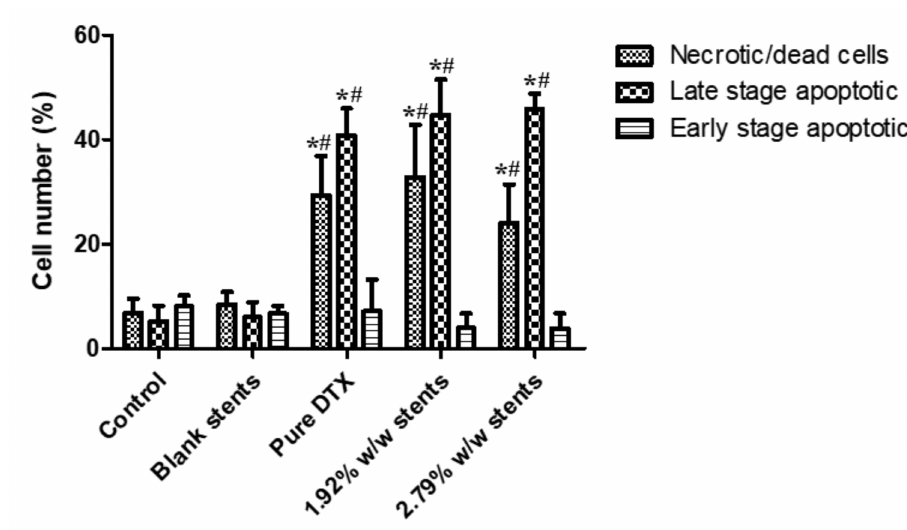
Figure 6. Apoptosis progression in KYSE30 esophageal cancer cells after treatment with blank (drug- free) stent, pure DTX drug (1 µ g/mL) and DTX-loaded stent samples for 48 h, as analysed by flow cytometry-based annexin V-FITC/PI double staining. Data are presented as the mean ± SD of at least three separate experiments. * p < 0.05 vs. control group. # p < 0.05 vs. blank stents. ( n =